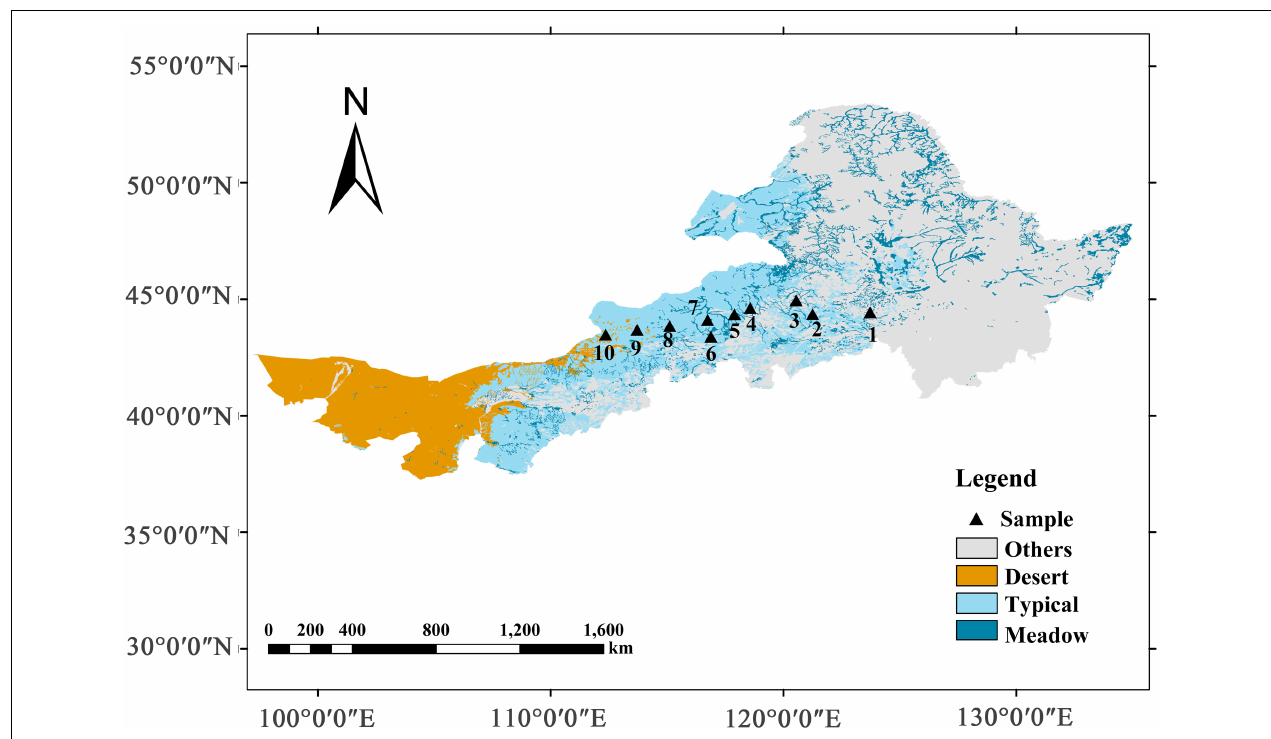
FIGURE 2 | Locations of field investigations along a north-east grassland transect in Inner Mongolia, China. Sampling sites were positioned along a precipitation gradient from east to west, which included three types of grasslands: meadow grassland ( 1 – 3 ), typical grassland ( 4–7 ), and desert grassland ( 8–10